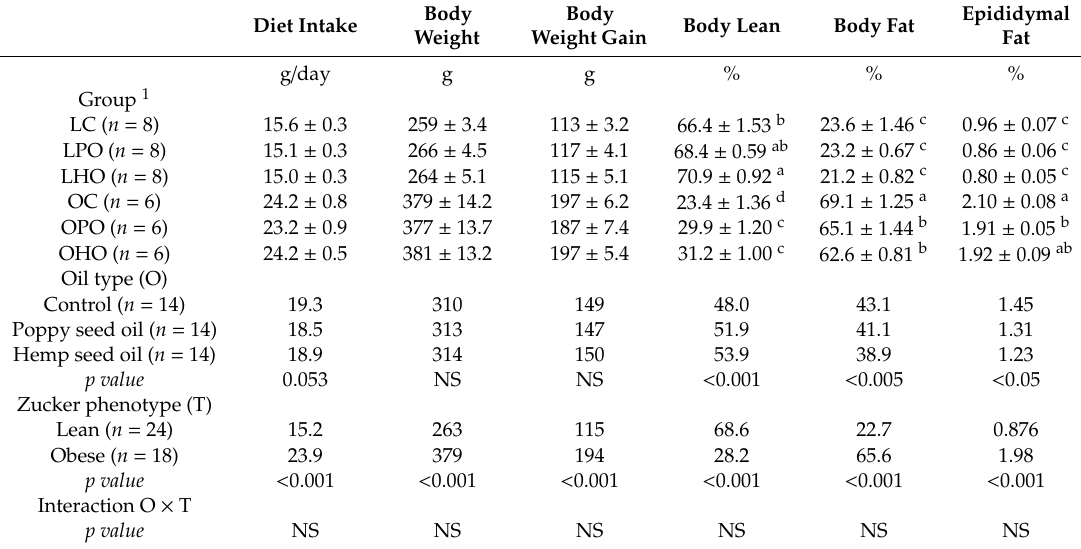
Table 1. Diet intake, body weight, and body composition of rats after 4 weeks of feeding with experimental diets.